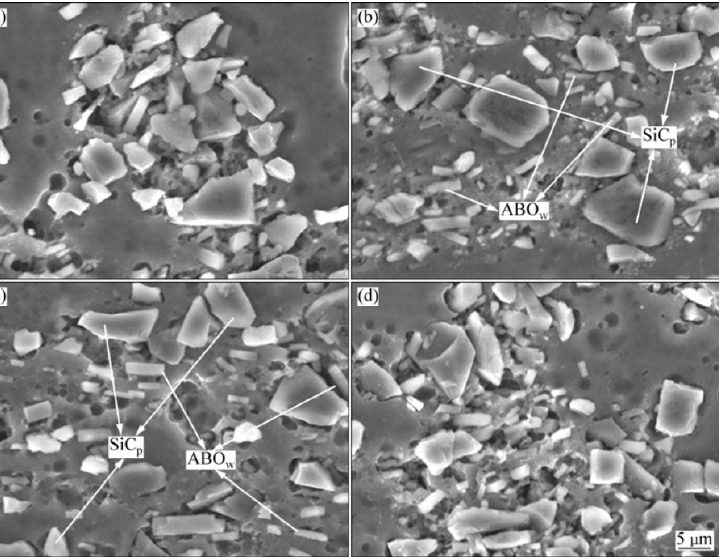
Figure 7. Micrographs of (5%ABO w + 15%SiC p )/6061Al composites fabricated at different stirring temperatures for 30 min: ( a ) 680 °C; ( b ) 650 °C; ( c ) 640 °C; ( d ) 630 °C [59].